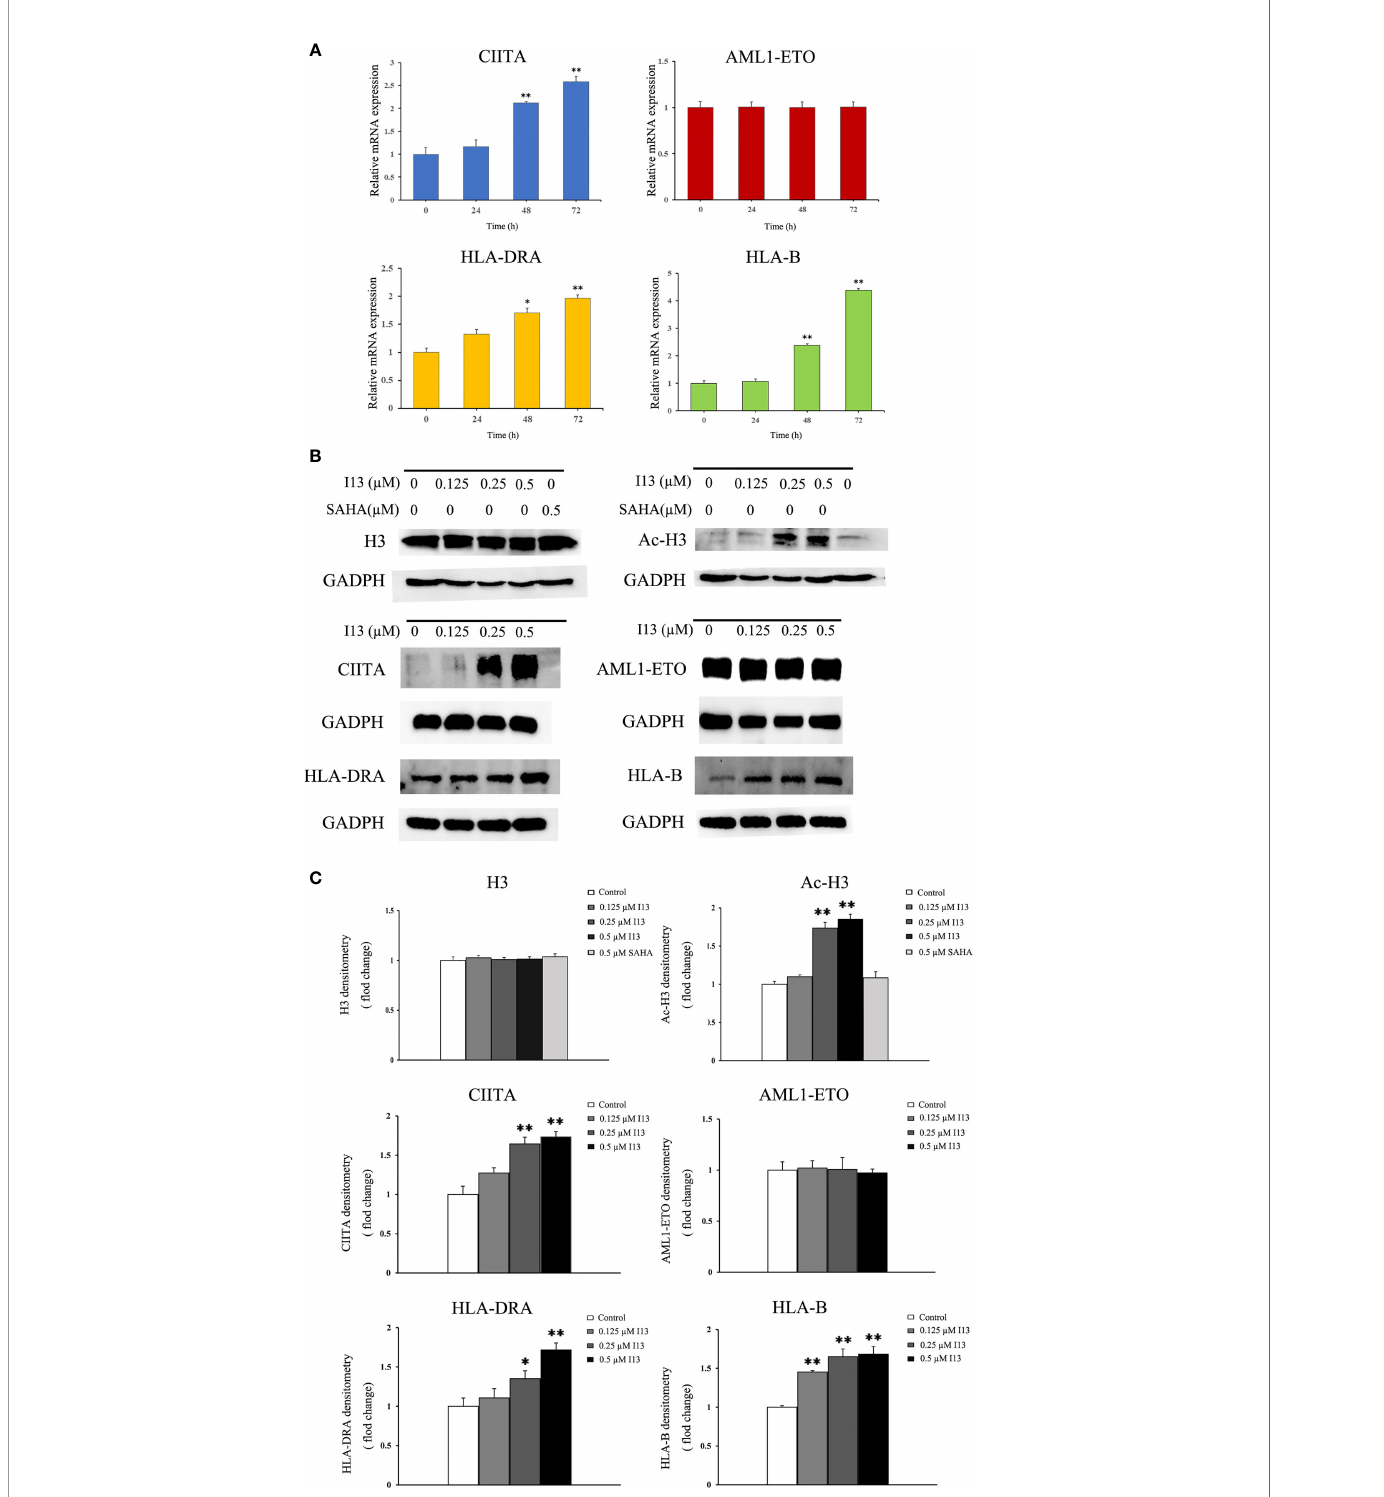
FIGURE 7 | The expression of several genes and proteins related to cell differentiation or enriched in antigen-processing and presentation-signaling pathways in Kasumi-1 cells. (A) The mRNA expression of CIITA, AML1-ETO, HLA-DRA and HLA-B via real-time PCR (B) The protein expression of Ac-H3, H3, CIITA, AML1- ETO, HLA-DRA and HLA-B via Western blotting. (C) Protein expression was quanti fi ed by the software AI600 images. Kasumi-1 cells were treated with I13 (0.5 µM) for 72 h. *p < 0.05 and **p < 0.01. The analysis was carried out three